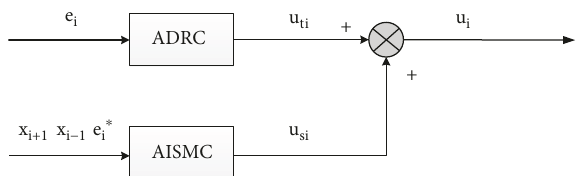
Figure 2: Block diagram of the controller for each motor.